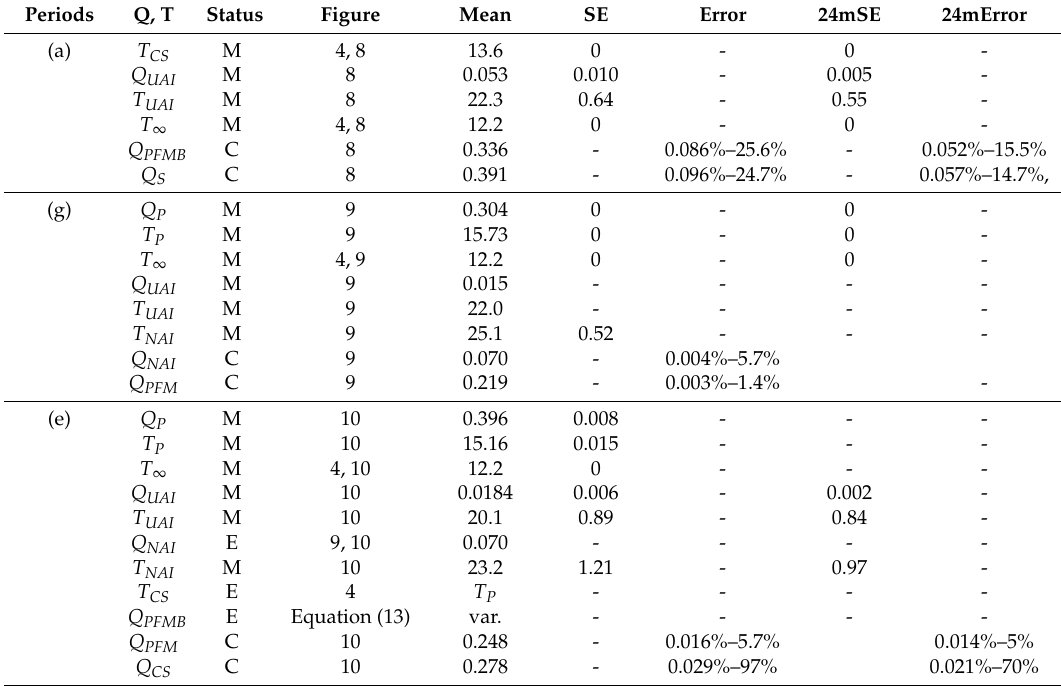
Table 4. Error assessments: Parameter, Status (M)easured, (E)xtrapolated or (C)alculated; Figure or Equation; Mean value; Standard Error; Max Error; Standard Error 24 h averaging, Min